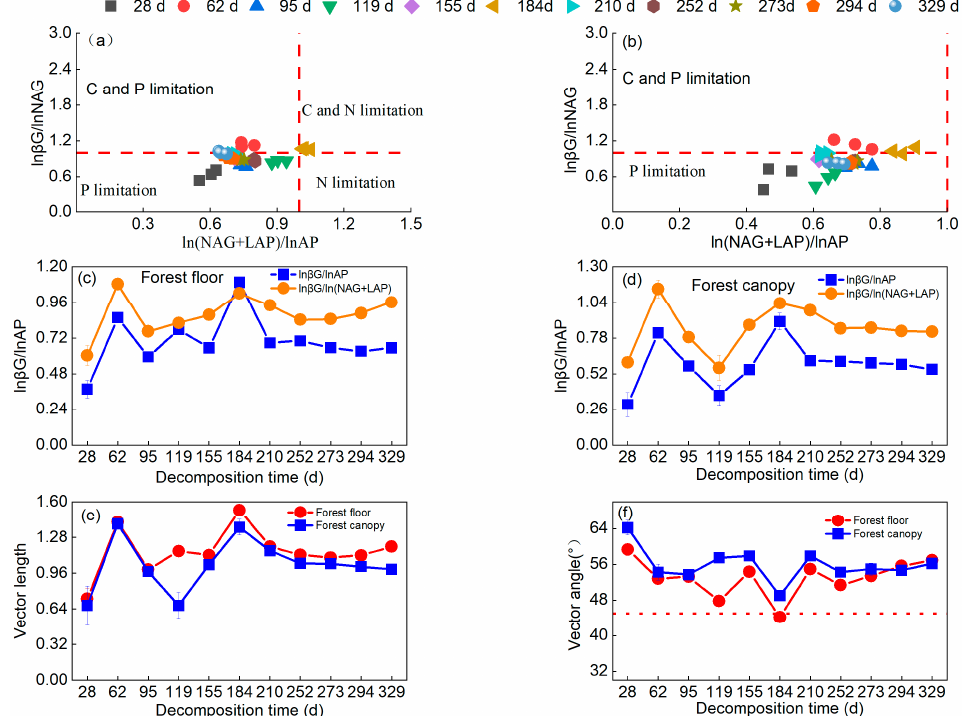
Figure 4. Carbon and nutrient limitation characterized by enzyme stoichiometry of litter leaves in the forest canopy and floor. ( a , b ): by using ln(LAP + NAG): lnAP as the x-axis and ln β G:ln(LAP + NAG) as the y-axis four different groups of microbial resource limitations (N limitation, P limitation, C and P limitation and N and P limitation) were categorized;( c , d ): when ln β G:ln(LAP + NAG) is higher than ln β G /lnAP, it denotes P limitation, when smaller it denotes N limitation of microbes; ( e , f ):changes of vector length and vector angle were calculated acording to the ratios of the log transformed β G, AP, NAG and LAP. The relatively long vector length represents a stronger carbon limitation; the angles <45 ◦ and >45 ◦ represent the relative degrees of N and P limitation,